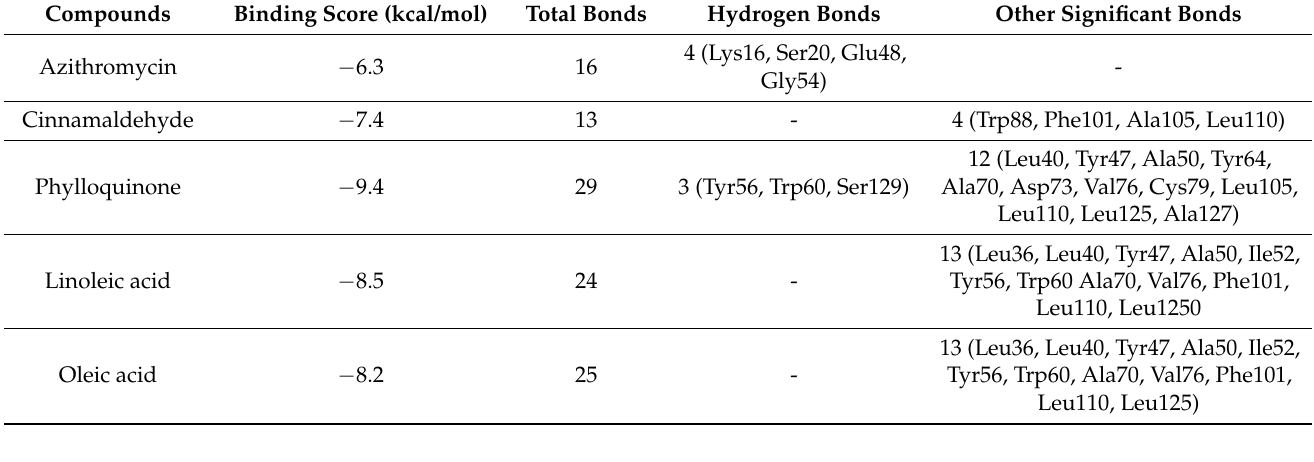
Table 6. Binding affinities and bonds formed between the top three compounds and LasR protein.